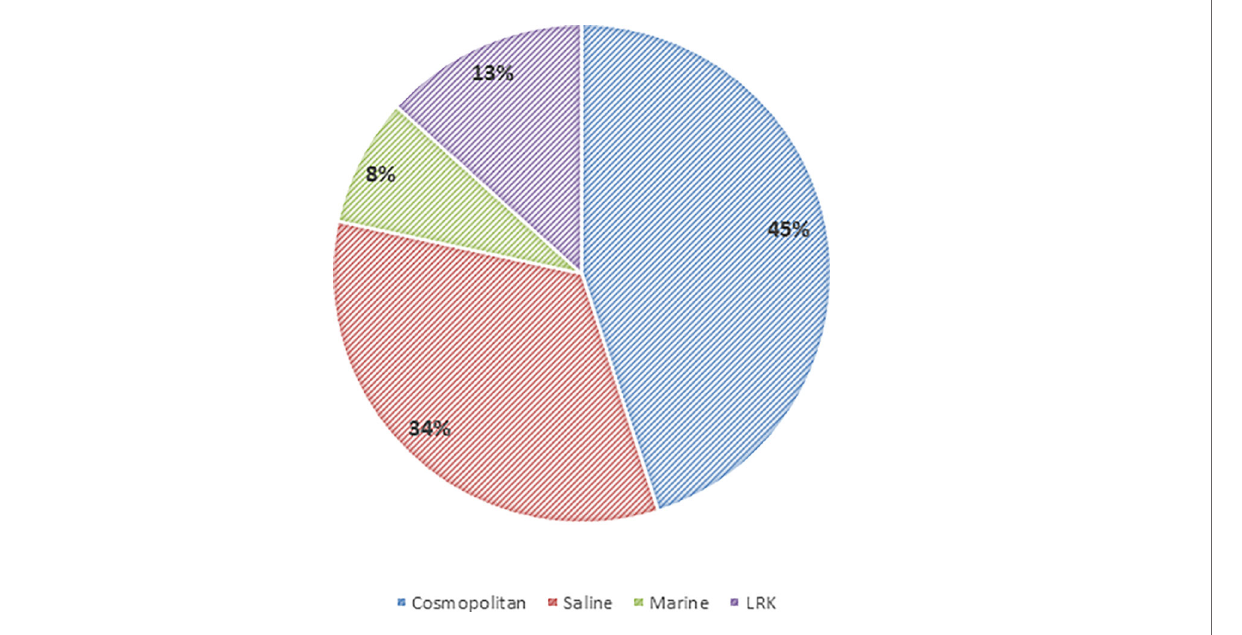
FIGURE 11 | Global geographical distribution of the phylotypes obtained from Little Rann of